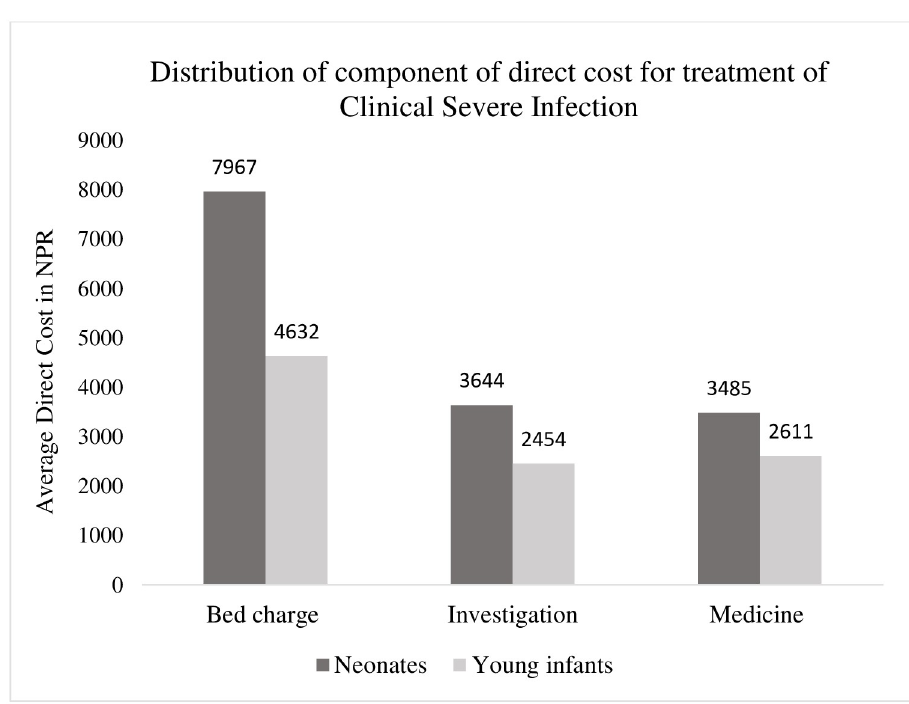
Fig 3. Distribution of components of direct costs for treatment of clinical severe infection in study participants admitted to Kanti Children’s